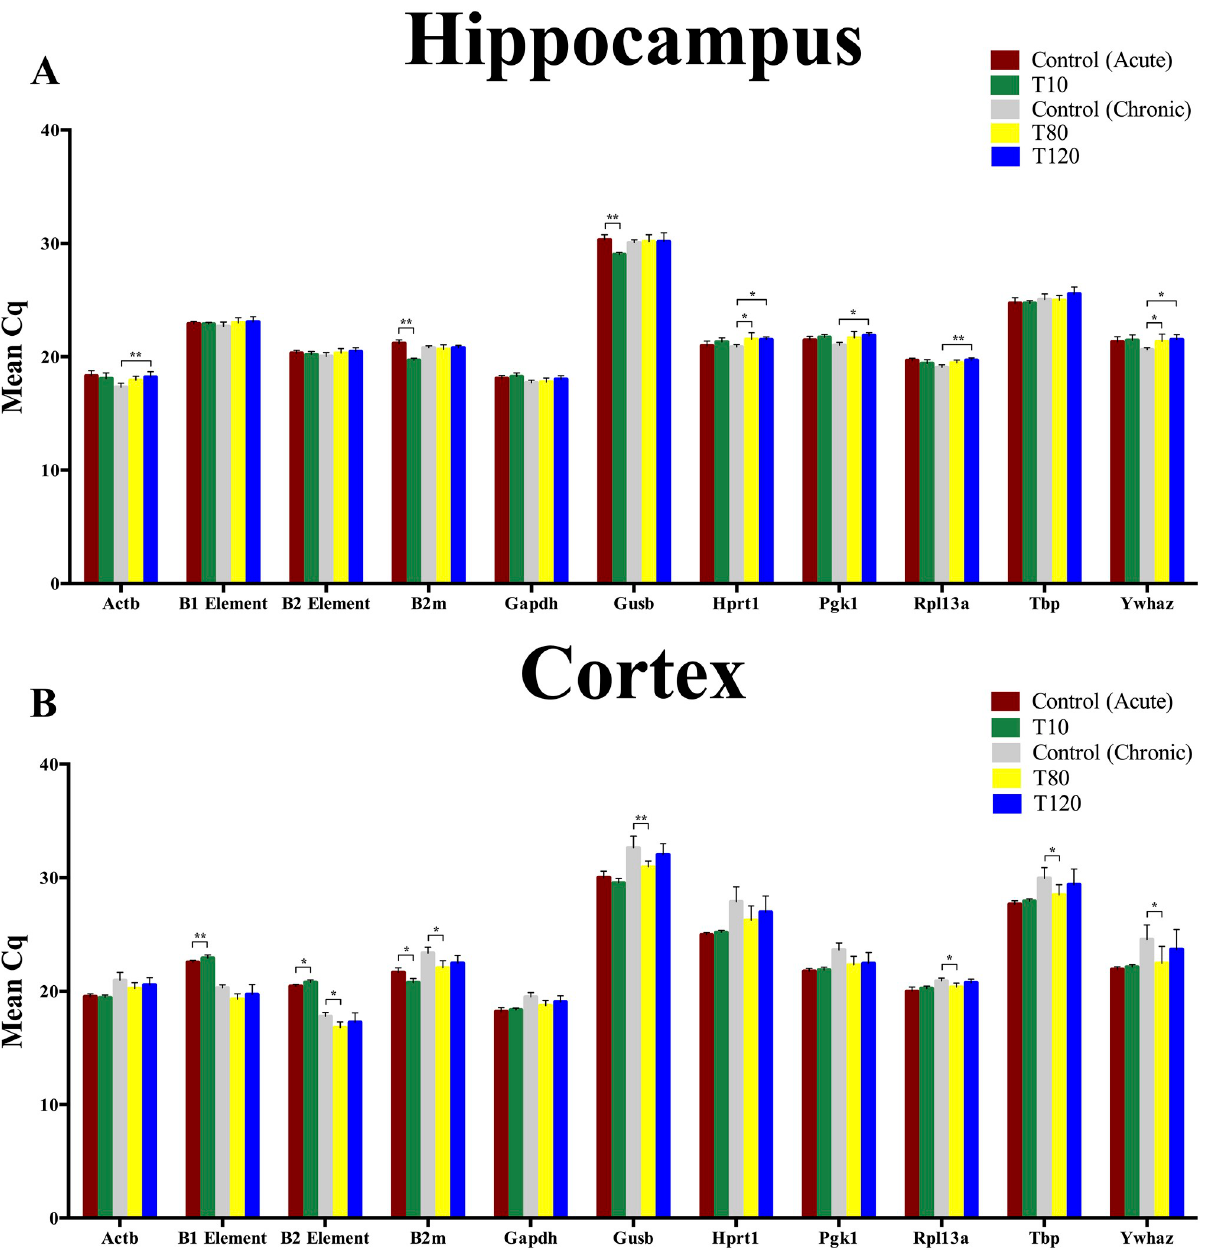
Fig 1. Cq values of the reference genes and B elements in hippocampus and cortex. (A) The mRNA expression profiles of the reference genes and B elements in the hippocampus of the acute phase (T10), the chronic phase (T80 and T120) in the KA model and their corresponding controls. (B) The mRNA expression profiles of the reference genes and B elements in the cortex of the acute phase (T10), the chronic phase (T80 and T120) in the KA model and their corresponding controls. Results are given in Cq values, mean ± SD (n = 6/7), during the acute phase (acute phase control vs. T10) and chronic phase (chronic phase control vs. T80/T120) phase, Mann-Whitney U Test or Kruskal-Wallis Test, respectively, � = P � 0.05 and �� P � 0.01.